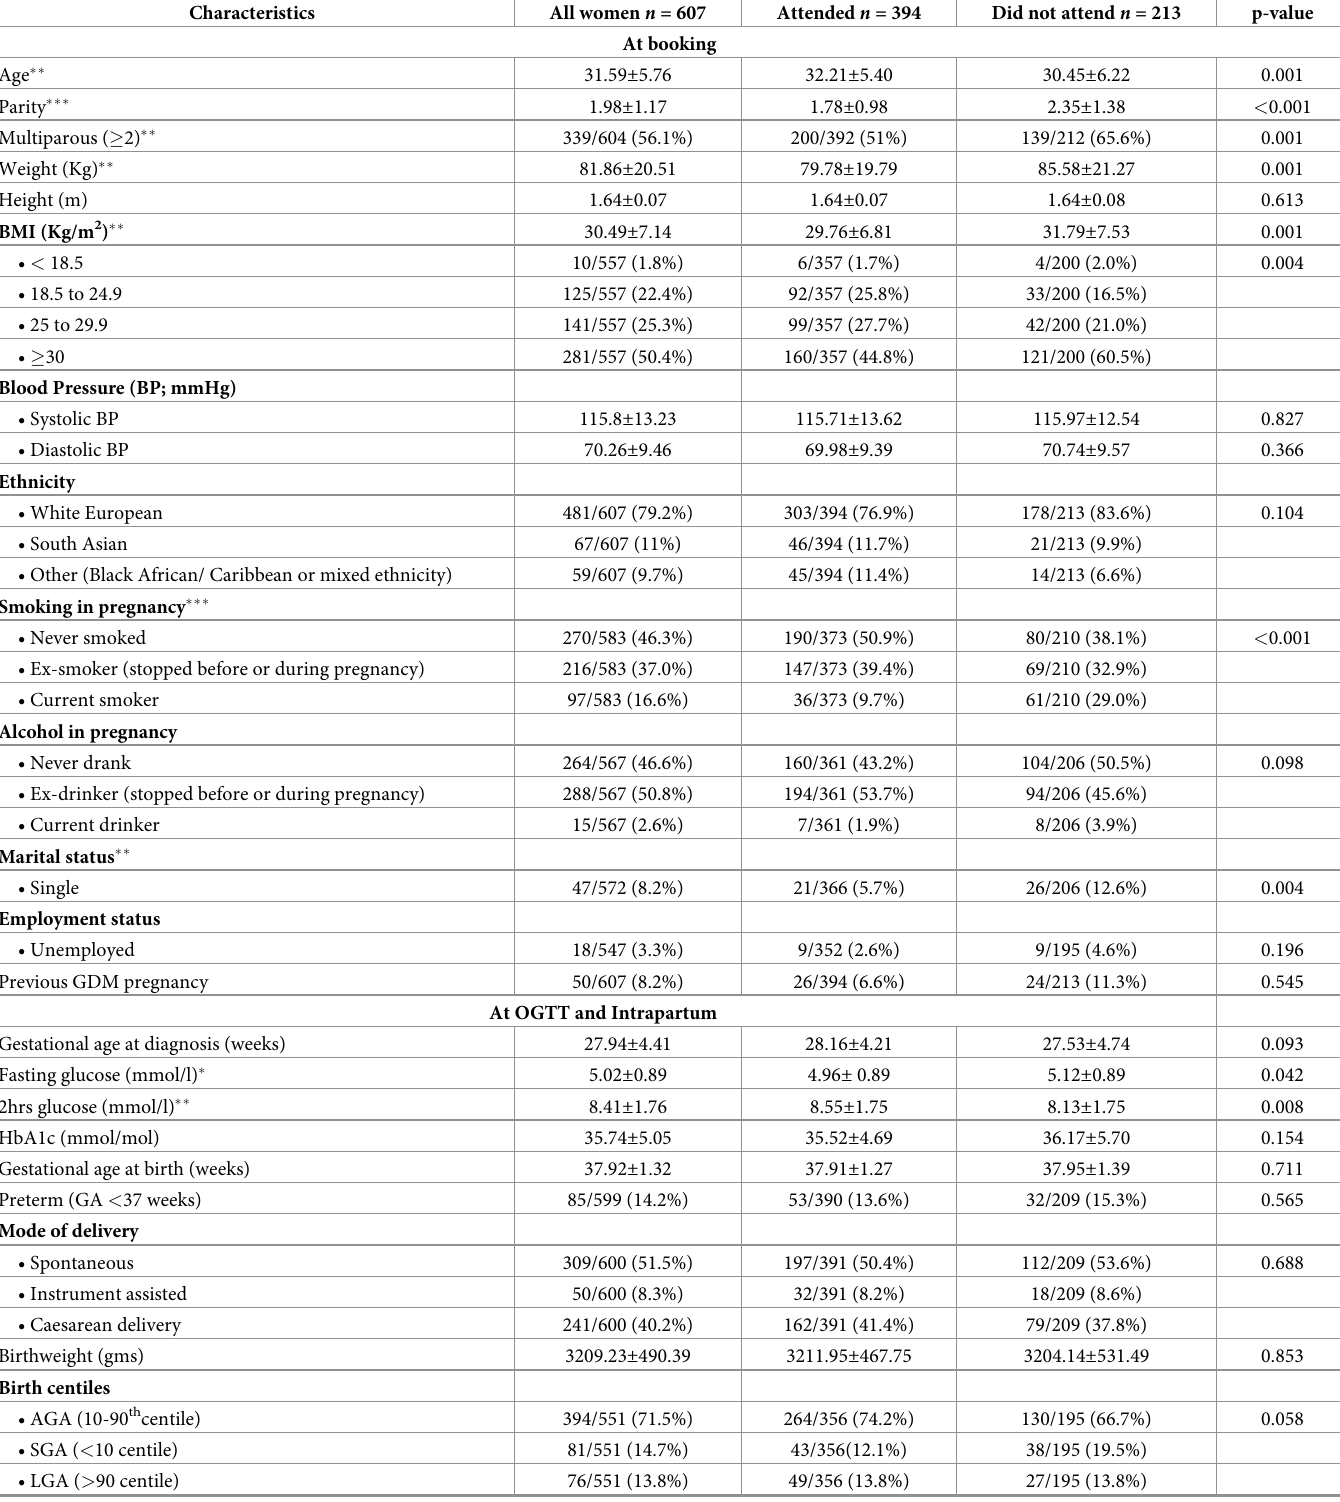
Table 1. Antenatal, delivery and postnatal characteristics of GDM women with postpartum glucose screening